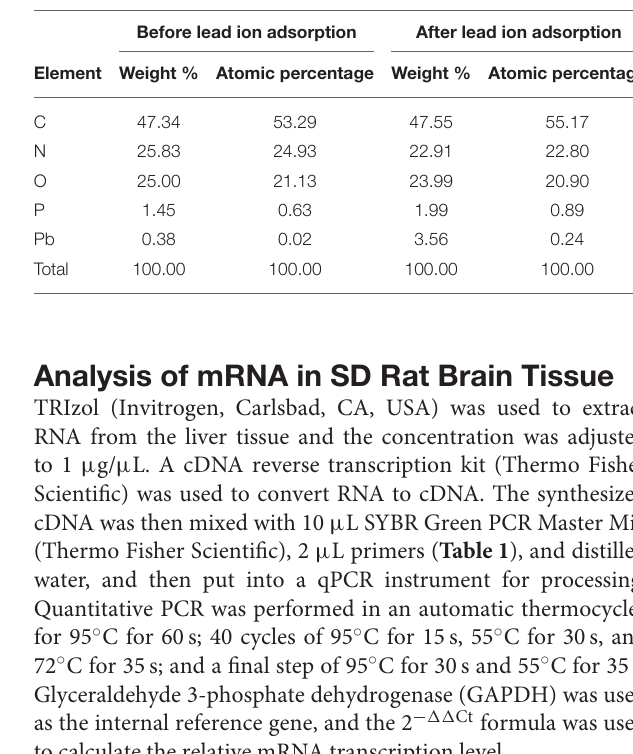
TABLE 2 | Weight and atom percent before and after of adsorption of lead